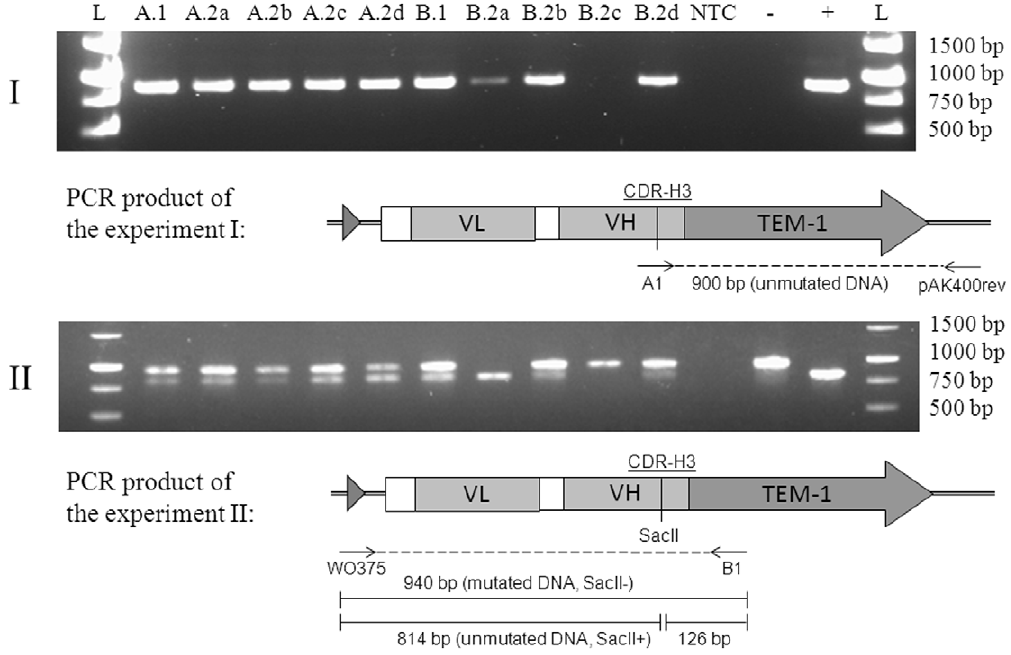
Figure 5. Colony PCR analysis of the progeny of two primary clones (A.1 and B.1) originating from the Kunkel mutagenesis of CDR- H3 loop. (I) PCR with wild-type-template- specific primer A1 and pAK400rev. 900 bp product is formed, if template is present. (II) SacII digestion analysis of PCR products (940 bp) primed with WO375 and B1 that hybridize outside the CDR-H3 loop. Both wild-type and mutated DNA is amplified, but only the wild-type DNA is cut to 814 bp and 126 bp fragments. (A.2a–d) Daughter colonies of A.1; (B.2a–d) Daughter colonies of B.1; ( 2 ) SacII resistant control, ( + ) SacII sensitive control, (L) 1 kb Fermentas DNA Ladder bands 1500–500 bp.